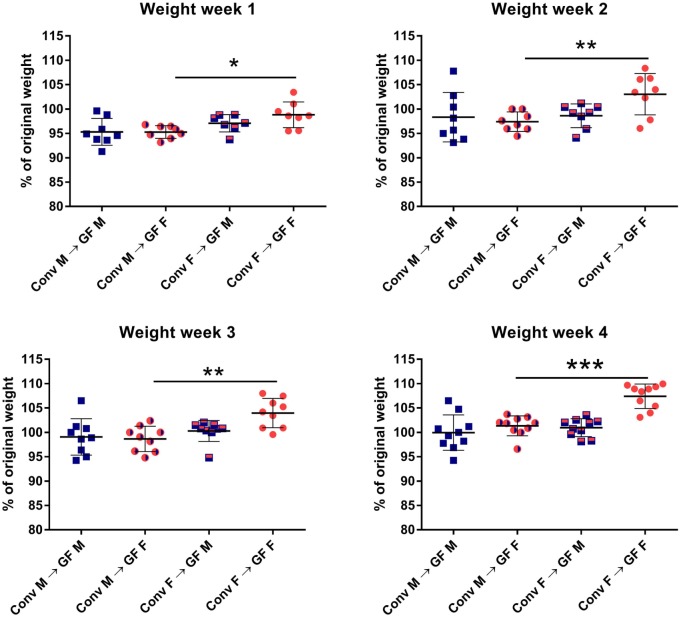
Feces of conventional (conv) males (M) or females (F) was transferred to germ-free (GF) male or female recipient mice (n = 10) by oral gavage. Weight was measured once a week for 4 weeks and is presented as the percentage of the original weight just before gut microbiota transfer. * indicates p < 0.05, ** indicates p < 0.01, and *** indicates p < 0.001.